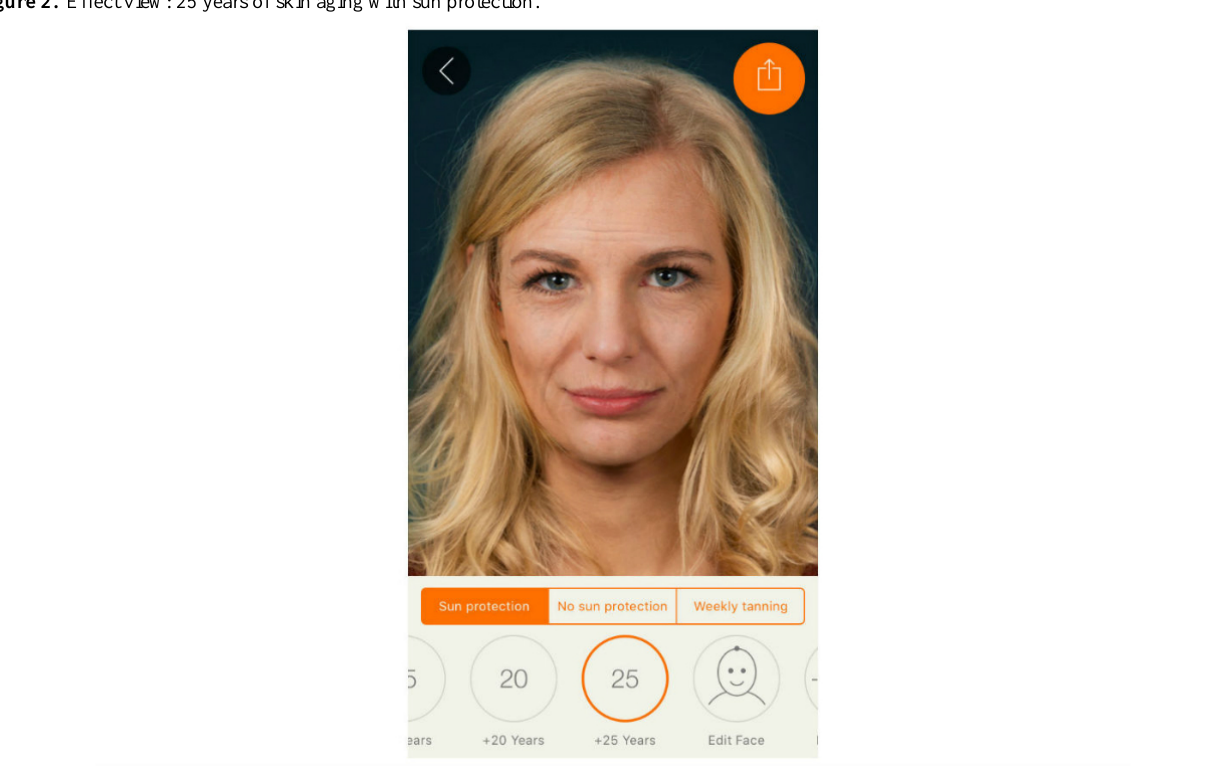
Figure 2. Effect view: 25 years of skin aging with sun